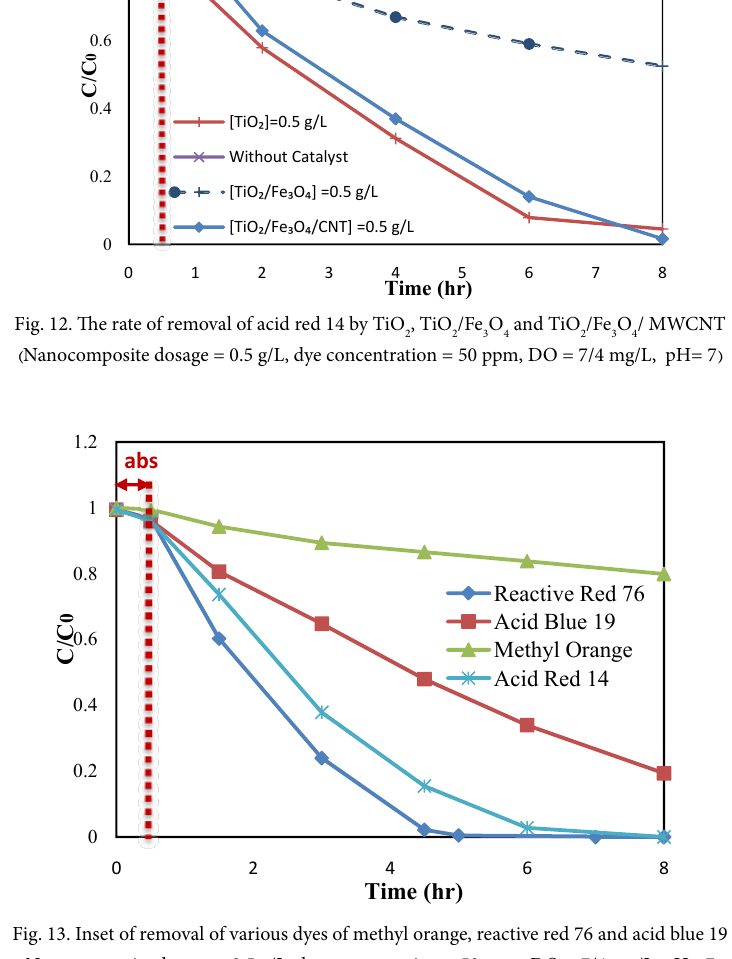
) Nanocomposite dosage = 0.5 g/L, dye concentration = 50 ppm, DO = 7/4 mg/L, pH= 7 (